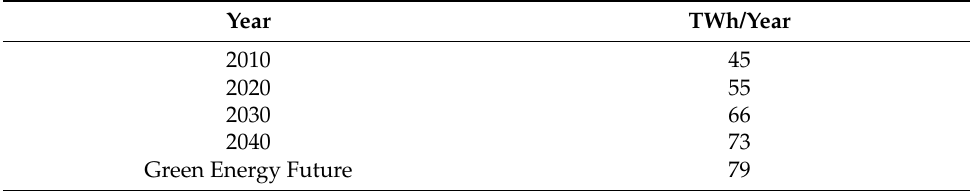
Table A4. Annual